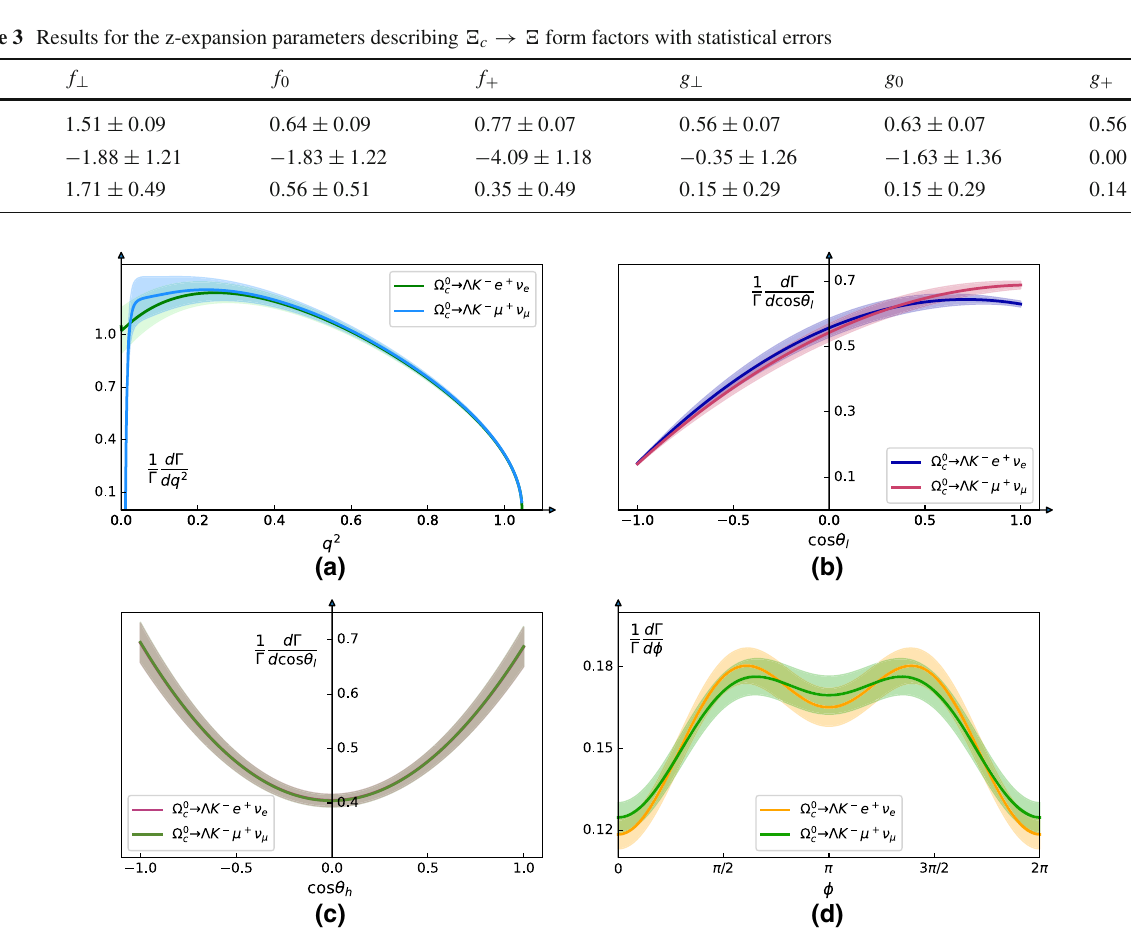
Fig. 5 Differential decay width for (cid:6) c → (cid:4) K − (cid:2) + ν (cid:2) as a function of q 2 ( a ), cos θ l ( b ), cos θ h ( c ), and φ ( d ). Note that in b and c , the errors increase with θ l from − 1 to 1 and θ h from 1 to − 1, as a result of the remarkable uncertainties of form factors at the small- q 2 region.